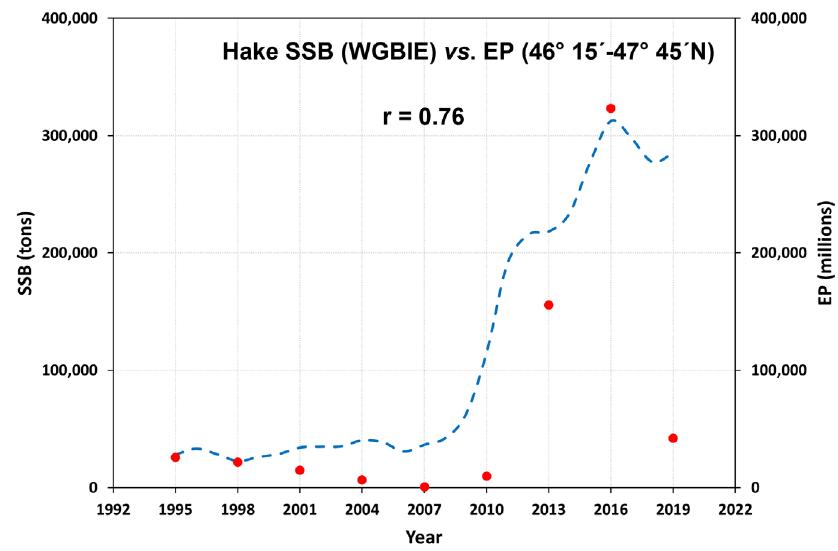
Figure 3. Historical estimations of the northern stock biomass of hake (SSB, tons) from the WG assessment (i.e., blue dashed line) in the subareas 4, 6, and 7, and in divisions 3a, 8a–b, and 8d (Source [37]) as well as egg production in the subareas 8a–b and 8d (i.e., red dots). Table 5. The parameters of the mortality exponential model fitted to the data of hake larvae abundance (number/m 2 ) by 1 mm length (mm). SL: Average larval length; SD: Standard deviation; Lo: Larval abundance at hatch; Z: Instantaneous mortality; R 2 : Coefficient of determination; p : Significant level; SvR: Survival rate; and T 20m : Temperature at 20 m depth ( ◦